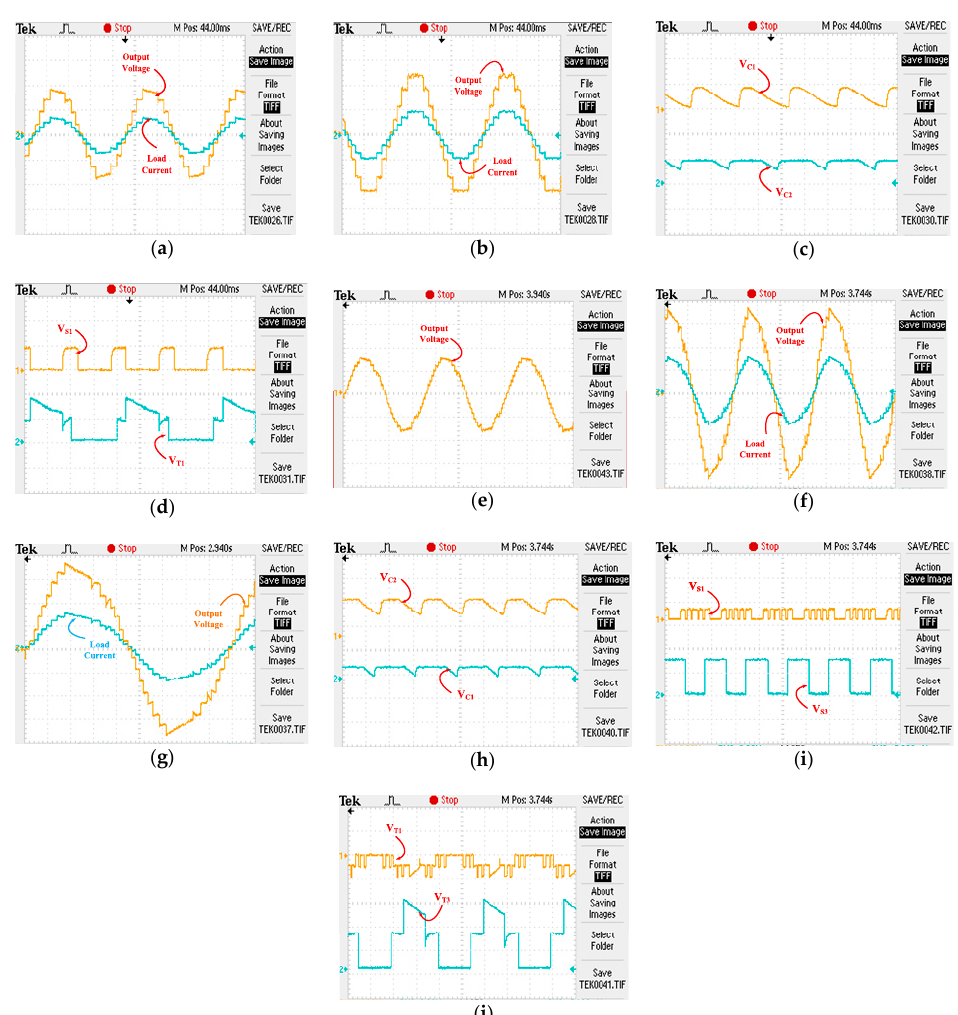
Figure 15. Waveform of ( a ) output voltage (25 V/div) and load current (1.5 A/div). ( b ) Output voltage (20 V/div) and load current (0.5 A/div) when the voltage supply of 12 V was connected across both capacitors. ( c ) Voltage across capacitors C1 and C2 (12 V/div). ( d ) Blocked voltage across switches S1 and T1 (12 V/div) in symmetric configuration. Waveform of ( e ) output voltage (60 V/div) under the no-load condition. ( f ) Output voltage (20 V/div) and load current (0.75 A/div). ( g ) Output voltage (20 V/div) and load current (0.75 A/div) for showing one complete cycle ( h ). Voltage across capacitors C 1 and C 2 (25 V/div). ( i ) Blocked voltage across switches S1 and S3 (25 V/div). ( j ) Blocked voltage across switches T1 and T3 (24 V/div) in asymmetric